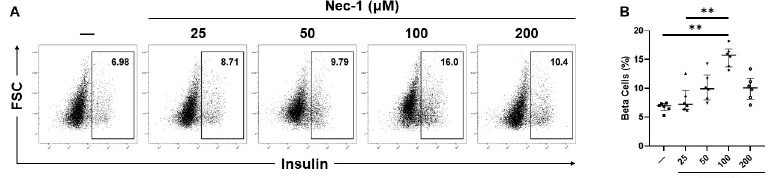
Fig 4. Beta-cell composition of islets after 7 days of tissue culture in control media (—) or media supplemented with 4 different doses of necrostatin-1 (25, 50, 100, or 200 μ M of Nec-1) on day 3. 3000 islet equivalents were dissociated into single cells using Accutase, stained with 7-amino-actinomycin D (7-AAD) viability dye and phycoerythrin-conjugated anti-insulin antibody, and analyzed by flow cytometry to quantify the proportion of beta cells in islets. Insulin-positive beta cells were gated on 7-AAD-negative live cells. A) Representative flow cytometry plots of insulin staining. B) Percentage of insulin-positive beta cells. n = 6 for each group. �� p < .01. Data are expressed as median and interquartile